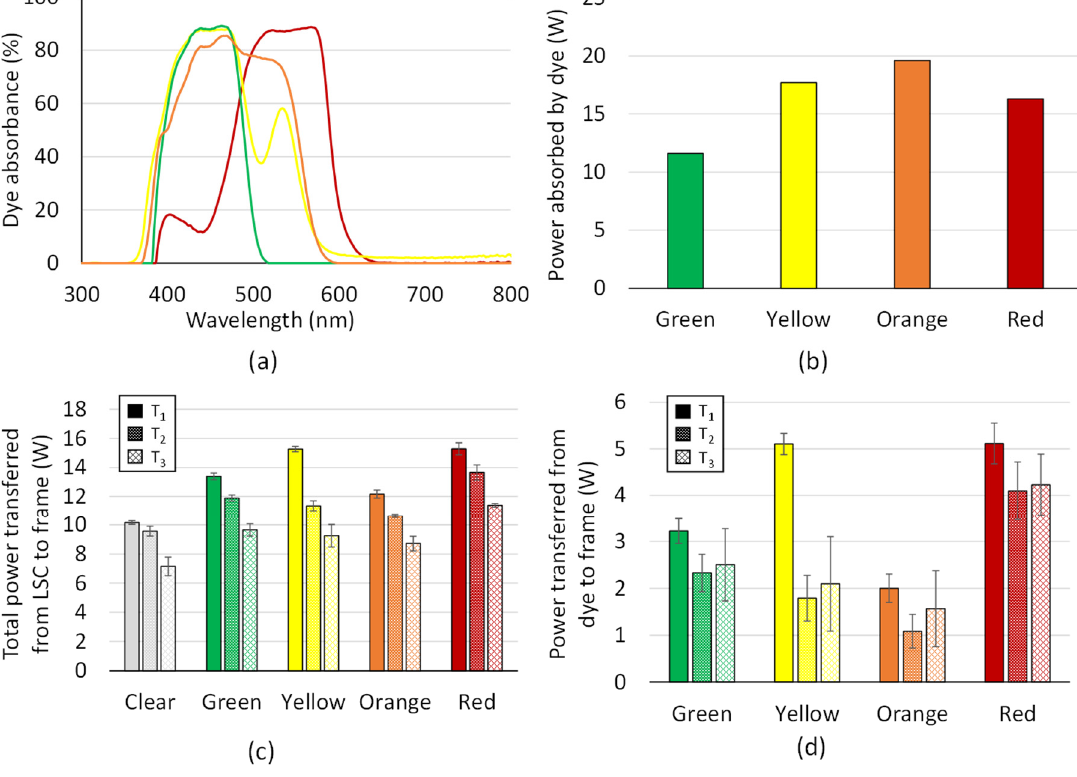
Figure 5. ( a ) Dye absorption spectra for the LSCs. ( b ) Radiant power absorbed by the dye within the LSC modules. ( c ) Thermal power transferred from the LSC to the frame. ( d ) Power photons emitted form the dyes within the LSC modules transfer to the frame at the edges of the LSC modules. For ( c ) and ( d ) the solid (left), trellis (middle), and diamond (right) patterns show results attained using thermocouples T 1 , T 2 , and T 3 , respectively (e.g., the thermocouples at positions one, two and three in Figure 3b, respectively). The error bars represent the standard